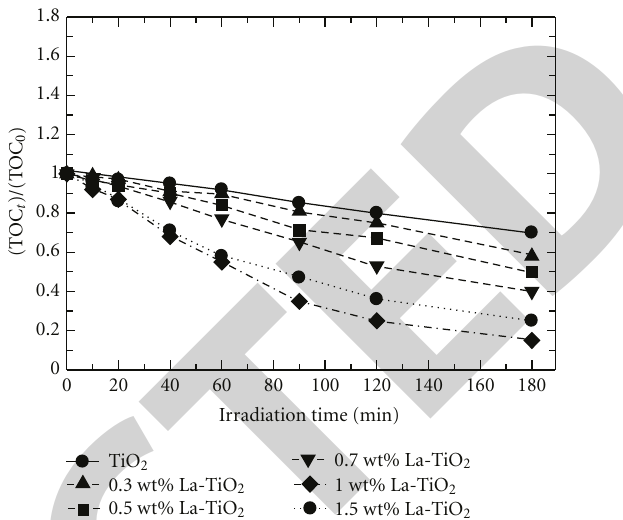
Figure 9: Comparison of photocatalytic mineralization of MCP using TiO 2 and La-doped TiO 2 photocatalysts. (MCP concentra- tion = 40 mg L − 1 ; catalyst amount = 100 mg/100mL; solution pH = 5; λ =